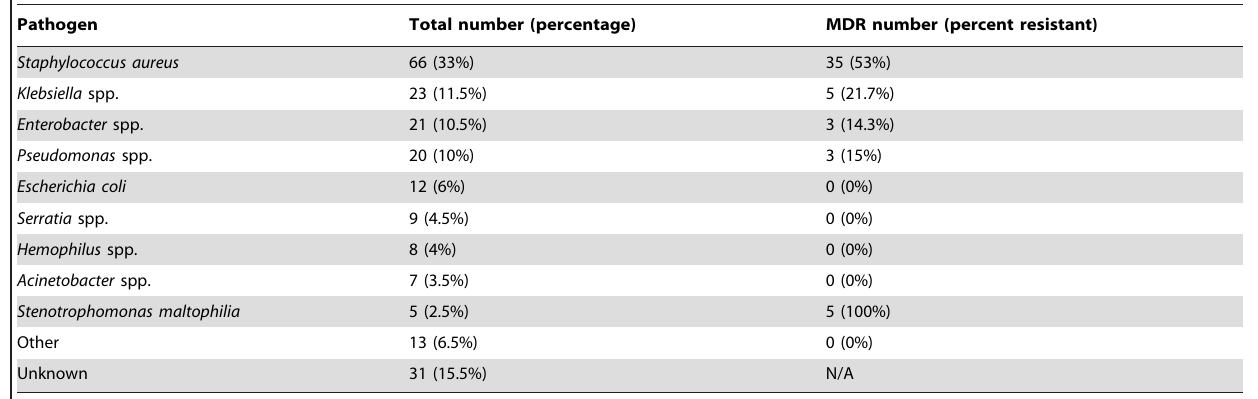
Table 1. Etiologic diagnosis of VAP and resistance profiles.